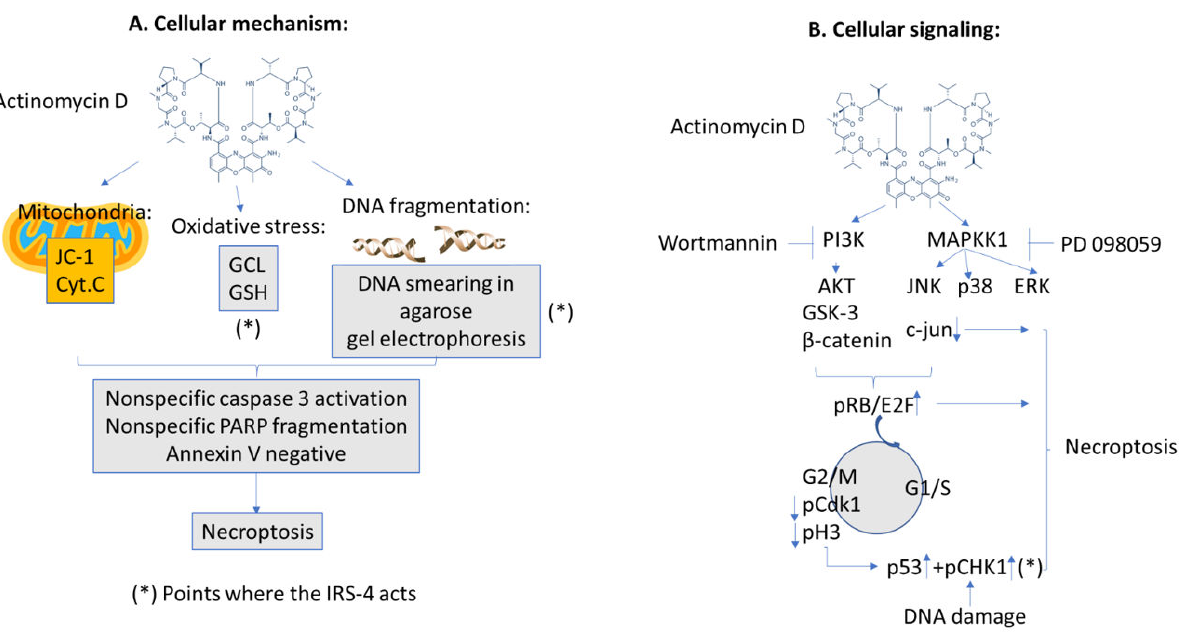
Figure 8. Schematic model of the results obtained in the present work. ( A ) Cellular mechanism of the work. ( B ) Cellular signaling of the